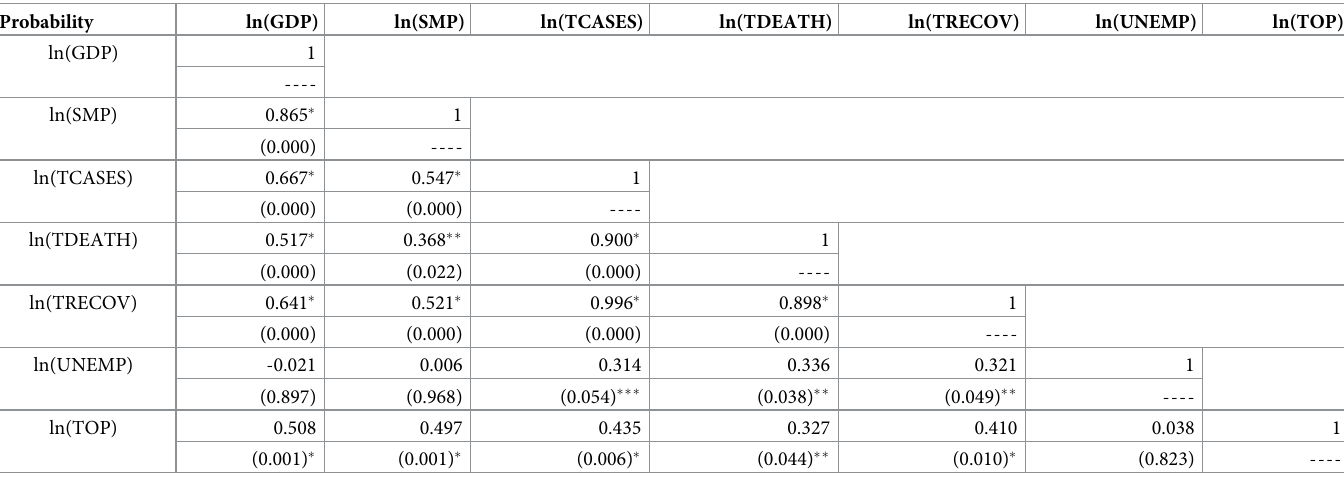
in a selected cross-section of countries. The average values of total deaths and total recovered cases are 120,831 and 5,726,754 respectively. The mean value of the natural logarithm of GDP